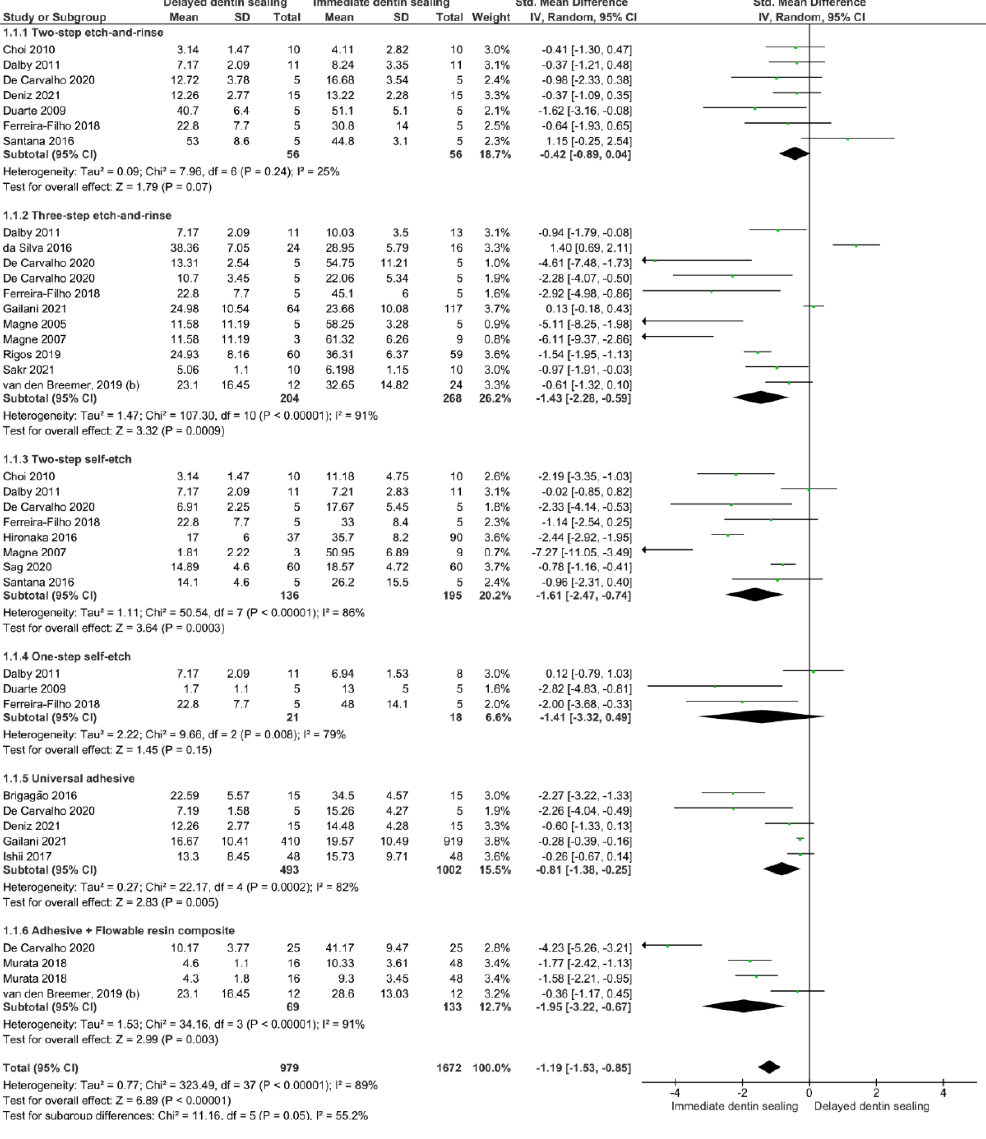
Figure 2. Forest plot of the immediate bond strength comparison between the delayed and imme- diate dentin sealing techniques according to the adhesive used. dentin sealing techniques according to the adhesive